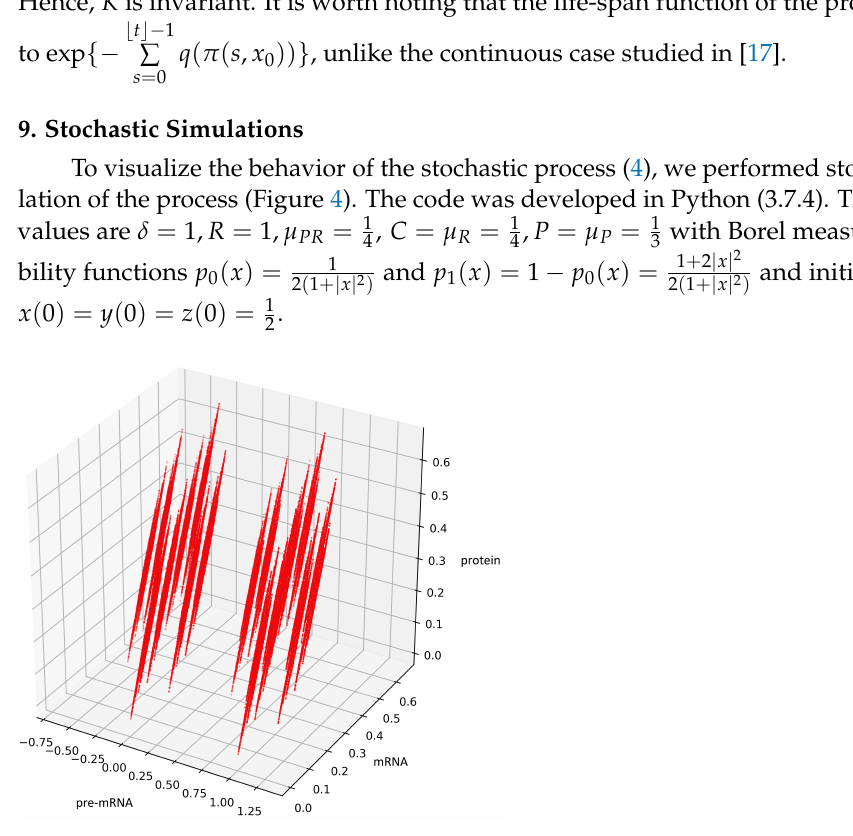
Figure 4. Visualization of the stochastic process (4), depending on two non-negative Borel measurable functions p 0 ( x )